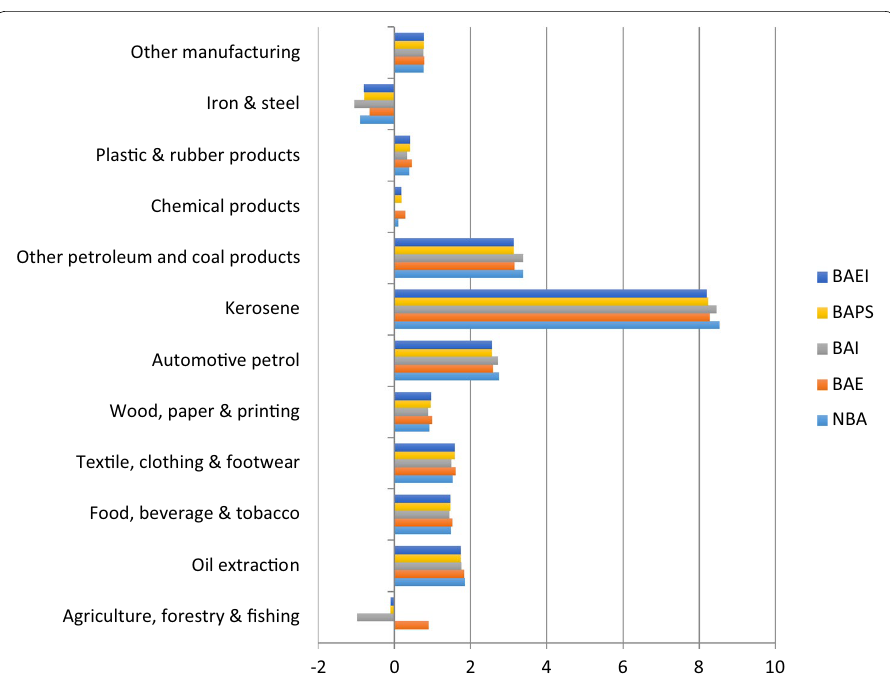
Fig. 6 Percentage change in import volumes by sector. Source Model